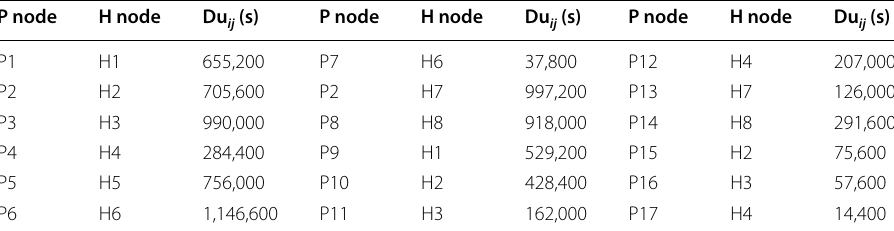
Table 2 Values of parameters for human nodes for the BDC Network P node H node Du ij (s) P